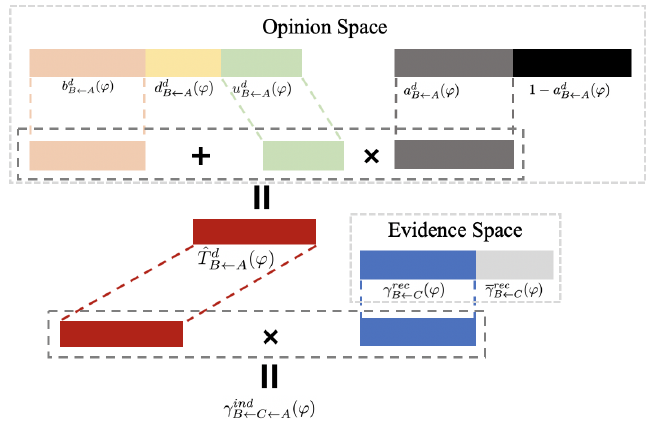
Figure 4. The design of discounting